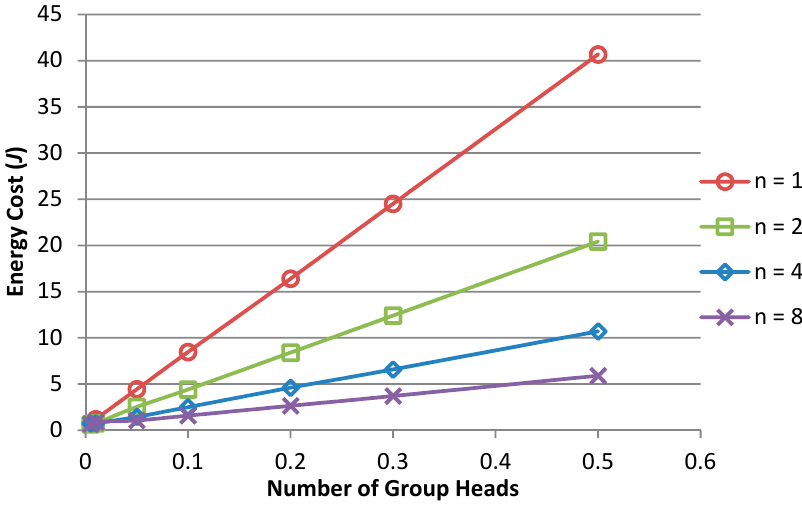
Figure 7. Effect of LUT at the end of the n th window ( n = 1, 2, 4 and 8).